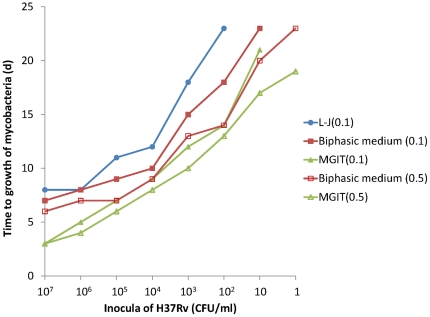
Growth of H37Rv culture on and in different culture media.For L-J (0.1), biphasic medium (0.1), and MGIT (0.1), a mean 0.1 ml of inocula were incubated. For biphasic medium (0.5) and MGIT (0.5), a mean 0.5 ml of inocula were incubated.